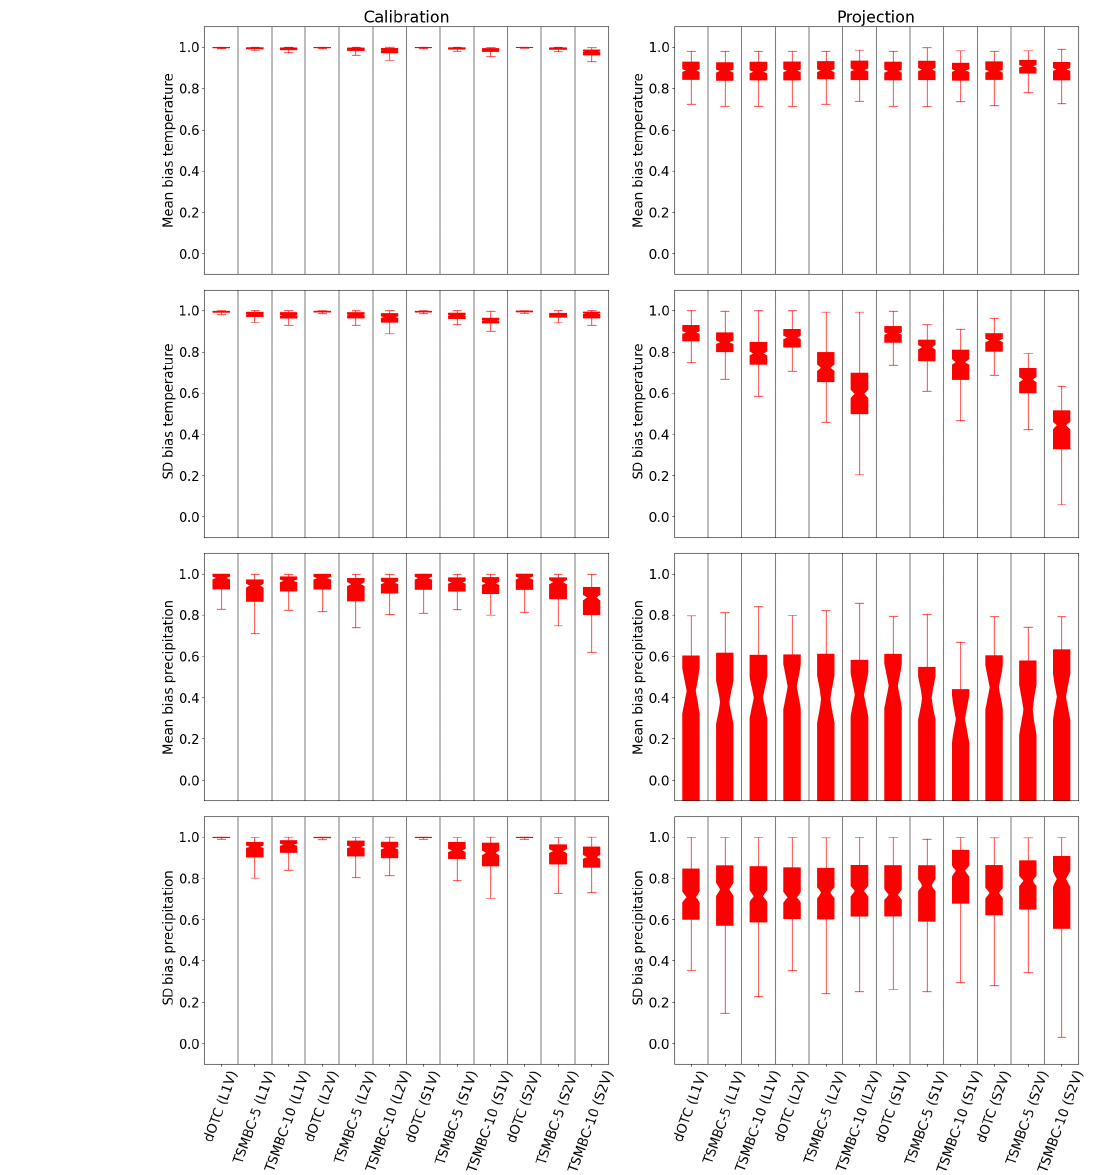
Figure 4. Boxplots of bias reduction in mean and standard deviation (BR E and BR σ ) in calibration (first column) and projection (second column) periods for temperature and precipitation in summer. The closer the boxplot is to 1, the closer the results are to the reference and therefore the better they